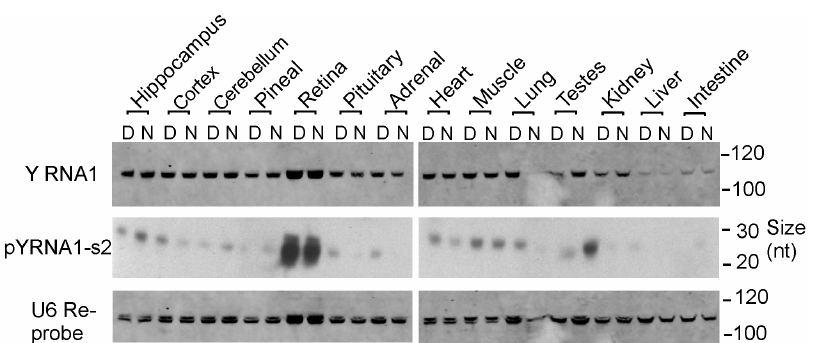
Figure 2. Tissue specific expression of pY RNA1-s2. Northern blotting of RNA extracted from the indicated tissue obtained during the Day (ZT 7) and Night (ZT 19). Tissues from three rats were pooled and RNA was extracted as described in ‘‘Materials and Methods’’. Equal amounts (1 m g) of total RNA were separated on 15% TBE-Urea polyacrylamide gels, transferred and chemically cross-linked to the membrane, followed by probing with an LNA TM -probe, designed against pY RNA1-s2. For further details see ‘‘Materials and Methods’’. The upper panel; full-length Y RNA; middle panel, pY RNA1-s2; lower panel, U6 as loading control. This analysis was repeated two more times with similar results.